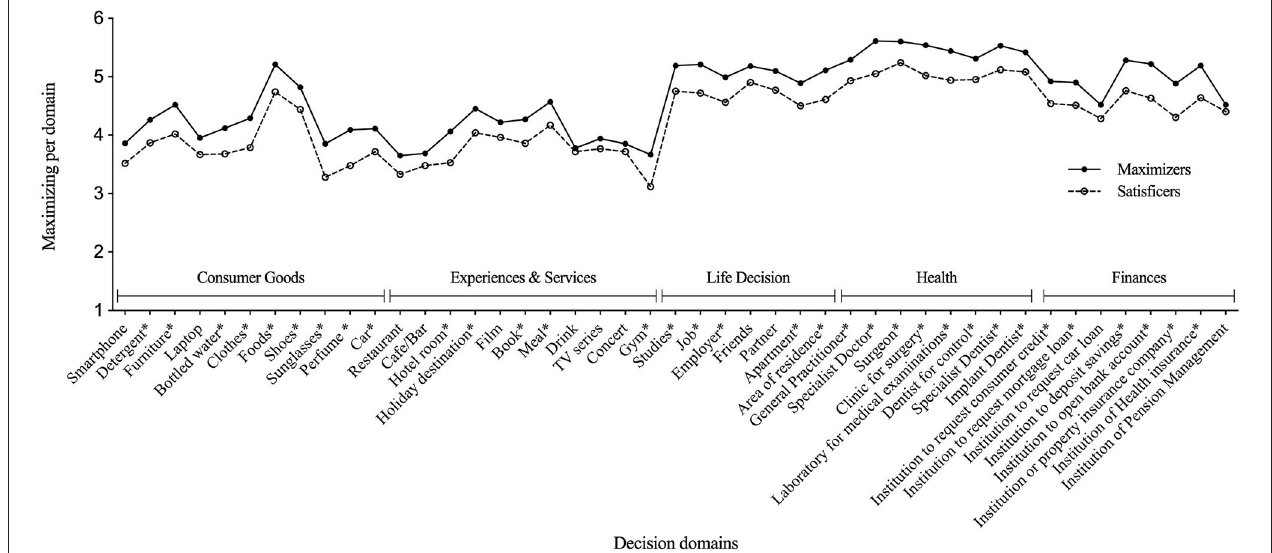
FIGURE 1 | Maximizers’ and satisficers’ maximizing tendencies in five decision domains. *Differences in the decision domain are statistically significant ( p <